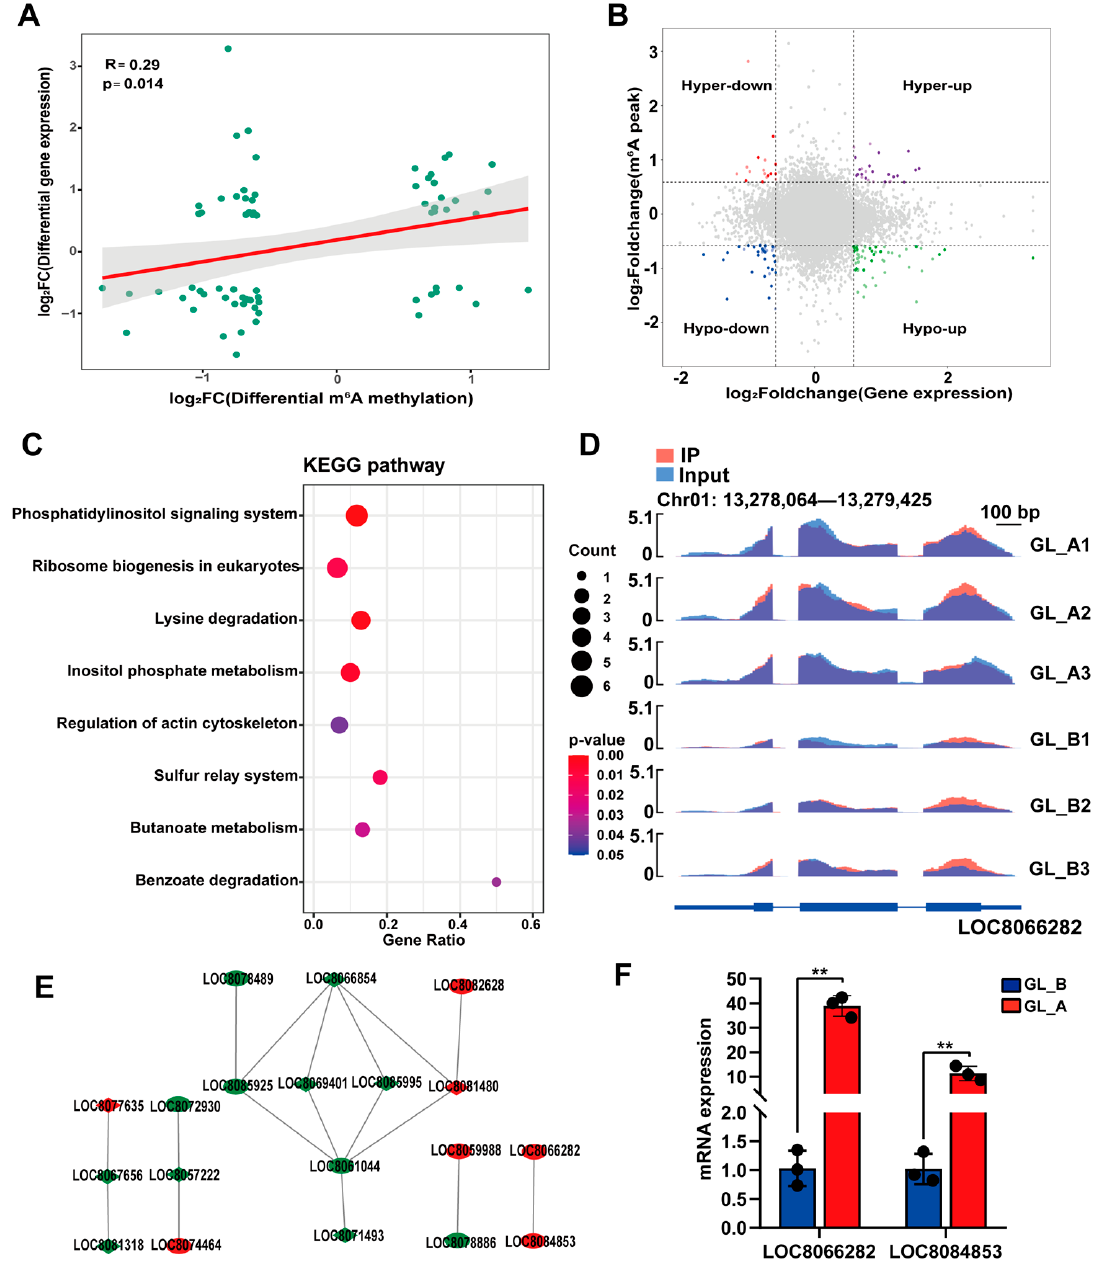
Figure 10. Combined analysis of the m 6 A- and RNA-seq data. ( A ) Log 2 FC (mRNA expression) versus log 2 FC (differential m 6 A methylation) dot plot depicting a strong and direct relationship between the sum of m 6 A-M and mRNA profile. ( B ) Four quadrant plots depicting DEGs with differ- entially methylated m 6 A peaks. Red dots represent the downregulated DEGs with hypermethylated m 6 A sites; Purple dots represent the upregulated DEGs with hypermethylated m 6 A sites; Green dots represent the downregulated DEGs with hypomethylated m 6 A sites; Blue dots represent the upregulated DEGs with hypomethylated m 6 A sites. ( C ) KEGG network enrichment analysis of genes depicting a considerable alteration in m 6 A and transcript expression. Different shades of colour represent the degree of significance. ( D ) m 6 A-modified LOC8066282 transcript data visualization. ( E ) Protein–protein interactions (PPIs) of genes with considerable alterations in m 6 A and mRNA transcript levels. Red annotated genes were upregulated DEGs in GL_A group, green annotated genes were downregulated DEGs in GL_A group. ( F ) Relative transcript expression, as evidenced by qPCR of critical genes in the examined leaves; ** p <